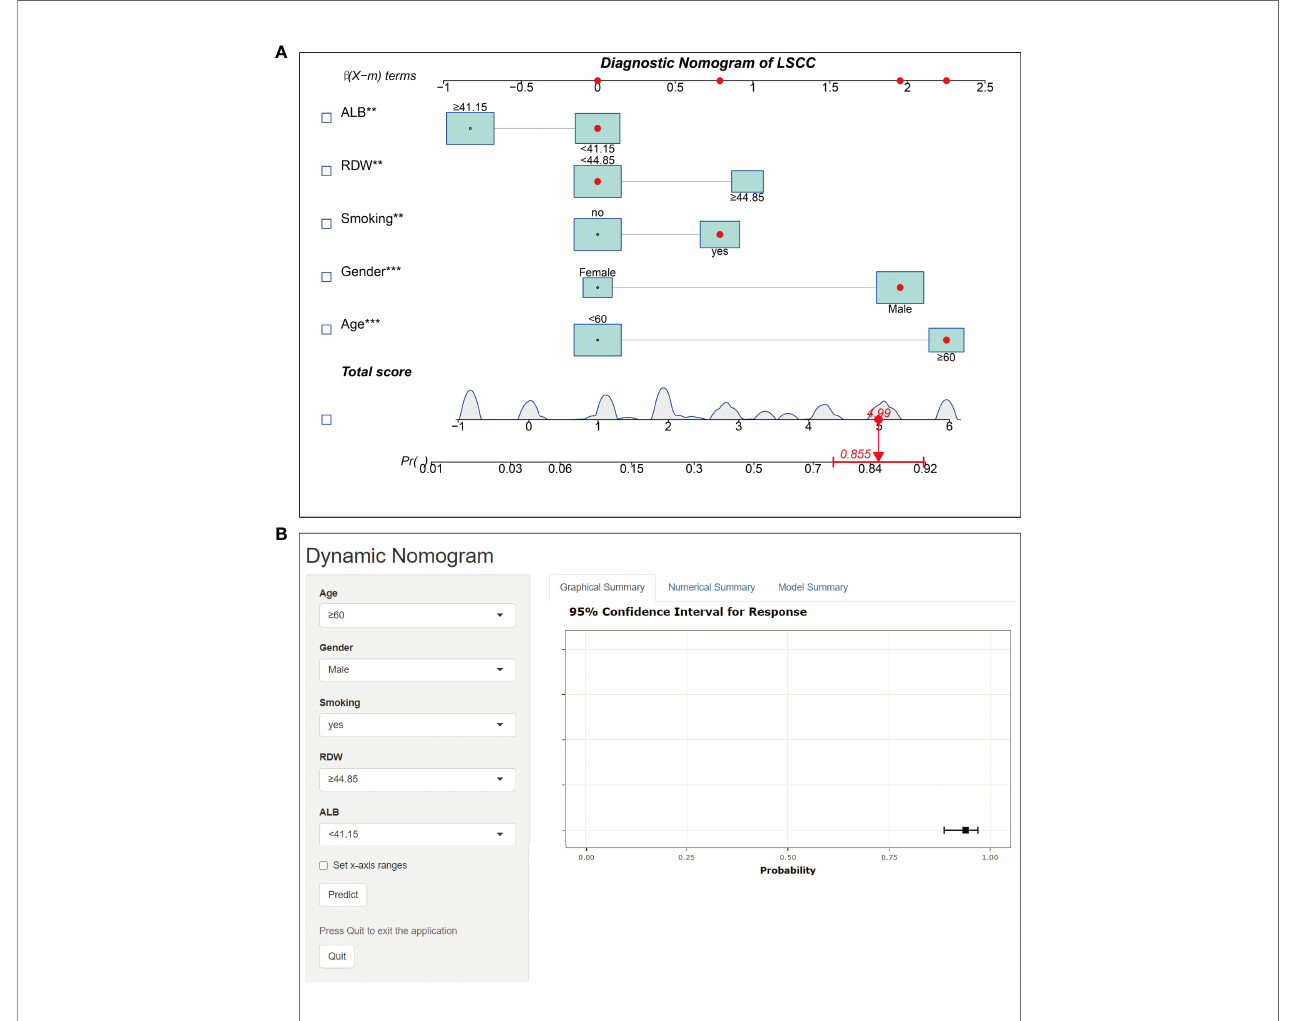
FIGURE 6 | Nomogram prediction model for LSCC diagnosis. (A) Established nomogram in the training cohort by incorporating the following fi ve parameters: age, sex, smoking history, RDW, and, ALB.** p<0.01, *** p<0.001. (B) Online dynamic nomogram accessible at